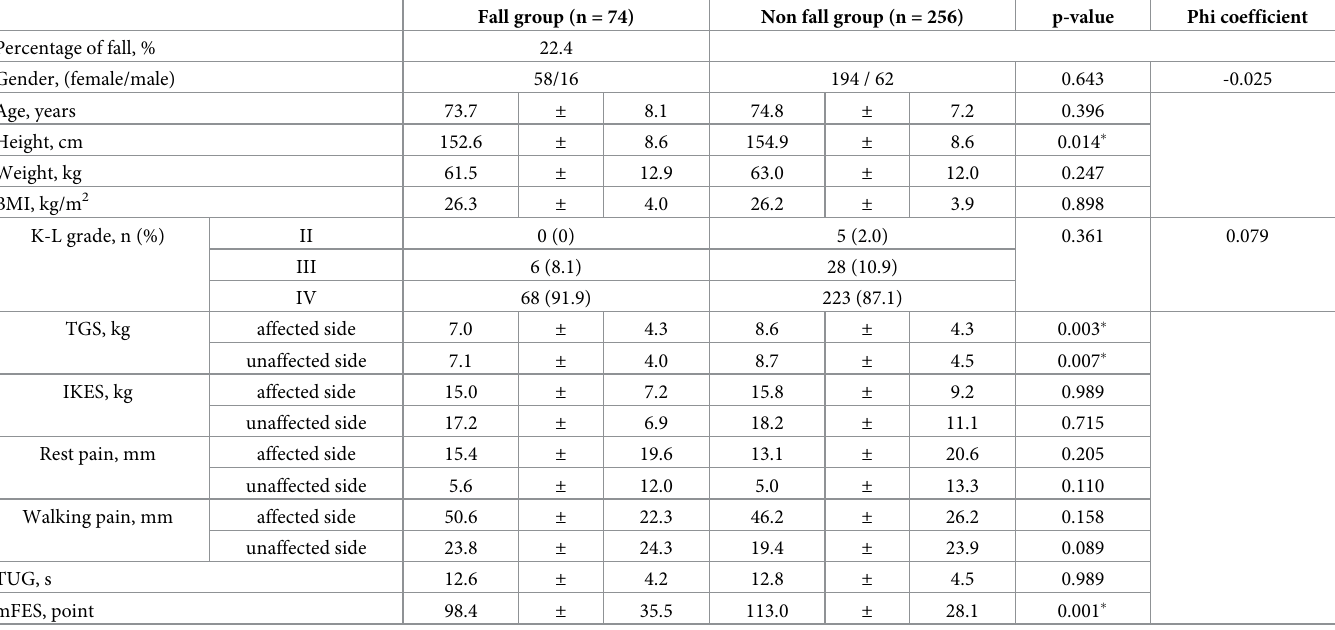
Table 1. Participants’ descriptive characteristics and descriptive statistics for the study variables (n = 330).